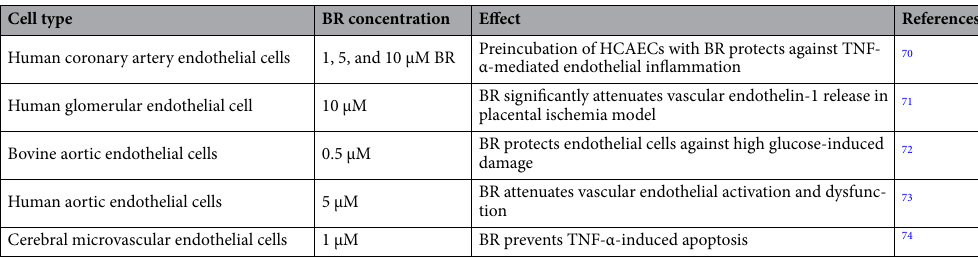
Table 2. Protective role of bilirubin against variety of cellular stresses in endothelial